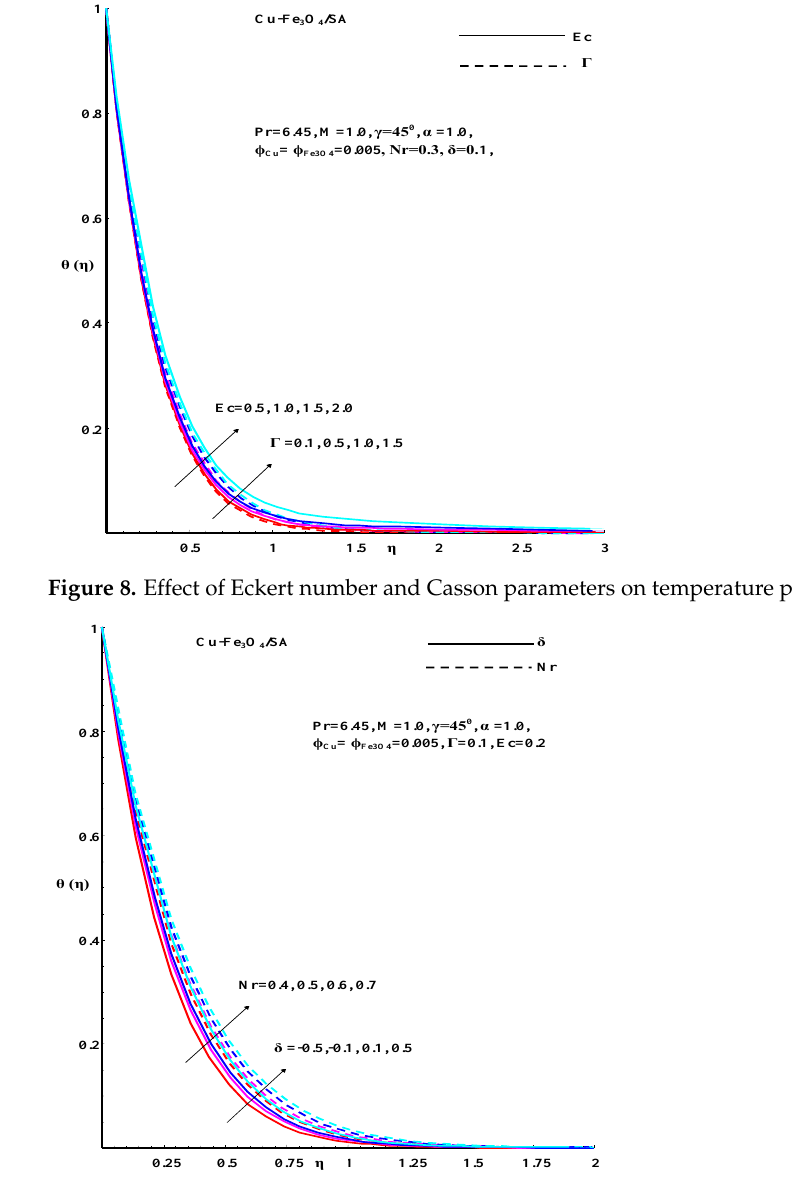
Figure 9. Effect of Nr and heat source/sink parameters on temperature